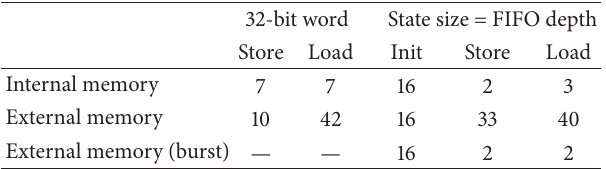
Table 2: Time consumed in state transference ( 𝑇 clock cycles per